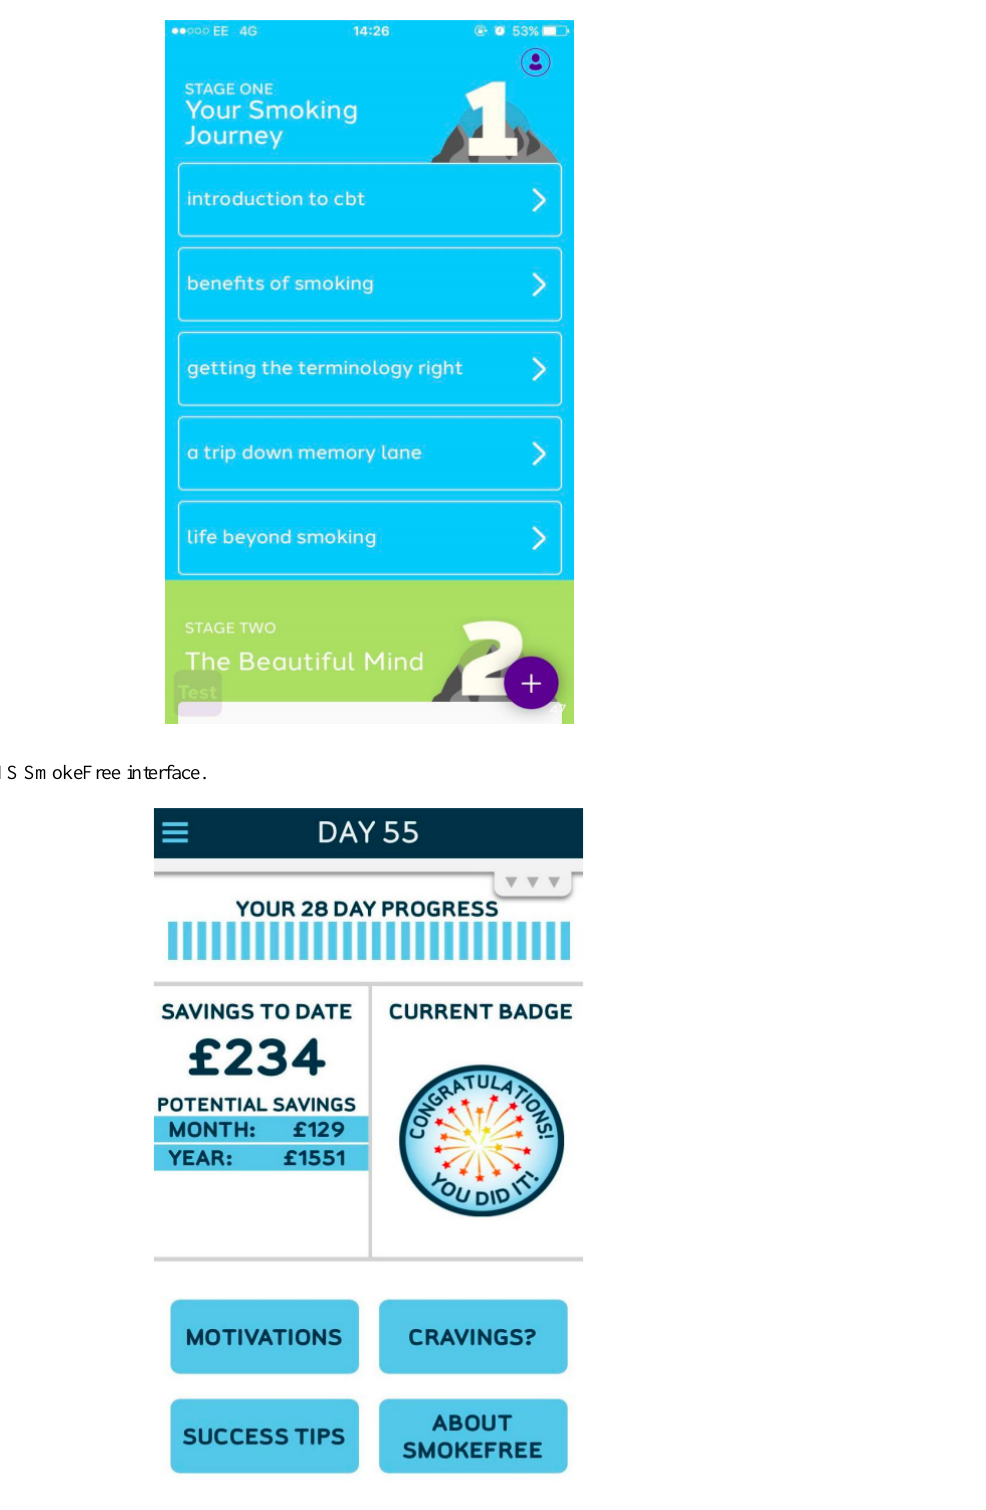
Figure 1. Screenshot of the Quit Genius interface. CBT: cognitive behavioral therapy.